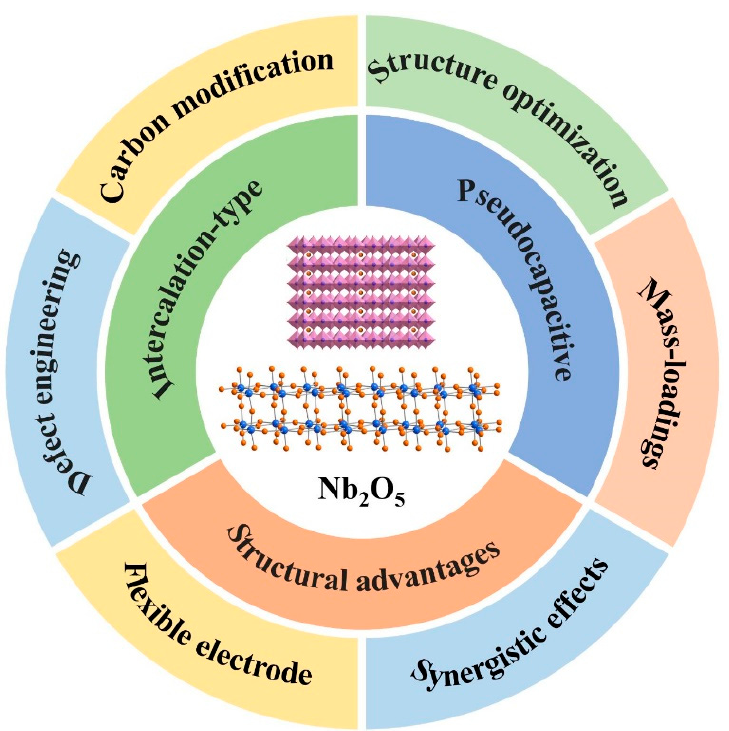
Figure 2. Energy storage characteristics and modification strategies of Nb 2 O 5 in